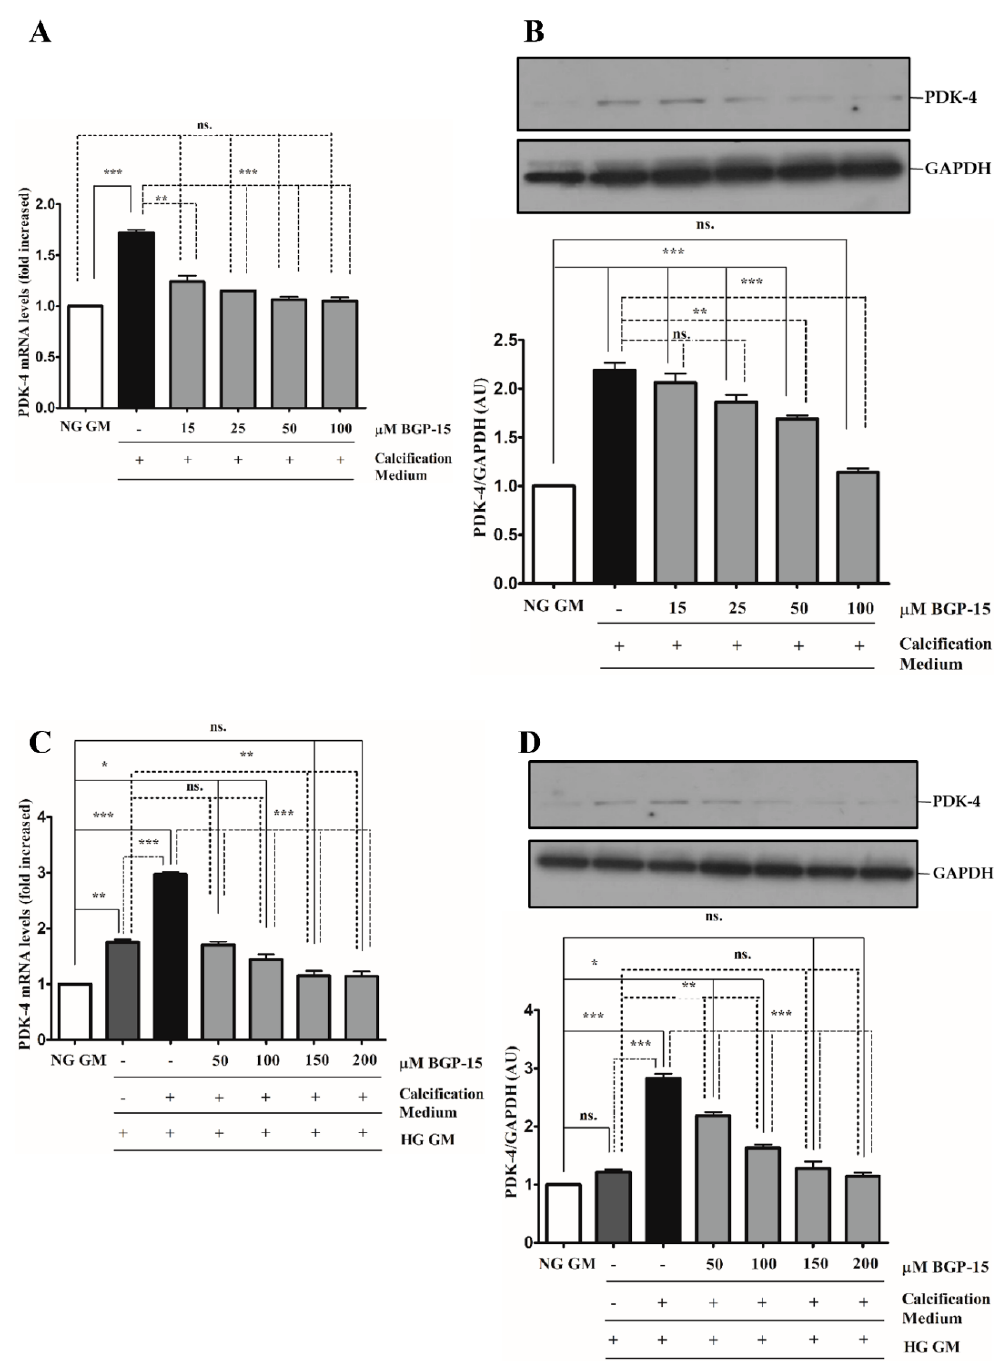
Figure 10. BGP-15 decreases PDK-4 expression induced by high Pi in NG and HG conditions. VSMCs were treated as in Figure 2. Expression of PDK-4 was analyzed by RT-qPCR and immunoblot ( A – D ). Relative expression of PDK-4 mRNA ( A ) and protein ( B ) in NG and HG (( C ): mRNA; ( D ): protein) conditions is presented as mean ± SEM of three independent experiments. Relative mRNA expression was normalized to RNA45S, while protein expression to GAPDH. Statistical analysis was performed by the one-way ANOVA test followed by Bonferroni correction. A value of p < 0.05 was considered significant. * p < 0.05, ** p < 0.01, *** p < 0.001.